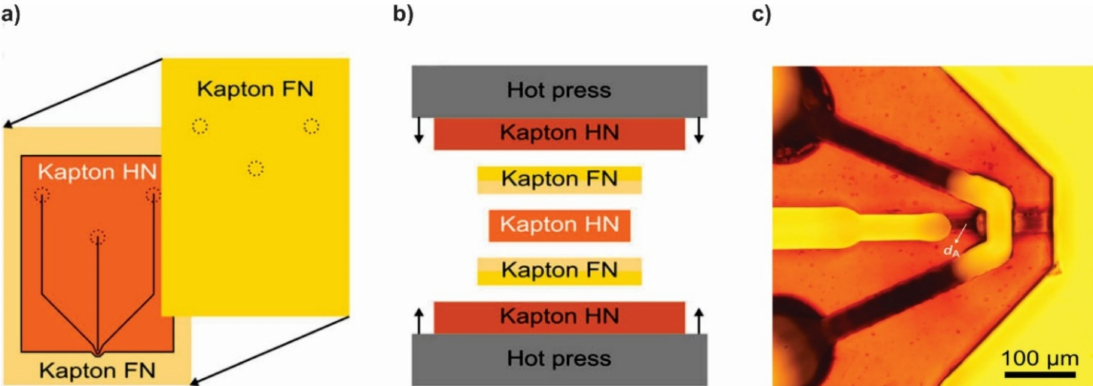
Figure 7. Schematic of the fabrication process of Kapton ® GDVN devices. ( a ) Alignment and hot embossing bonding of the Kapton ® foils, ( b ) stacking order of the bonding procedure, ( c ) microscopic image of the finished GDVN device showing gas and liquid microchannels (reproduced with permission from Reference